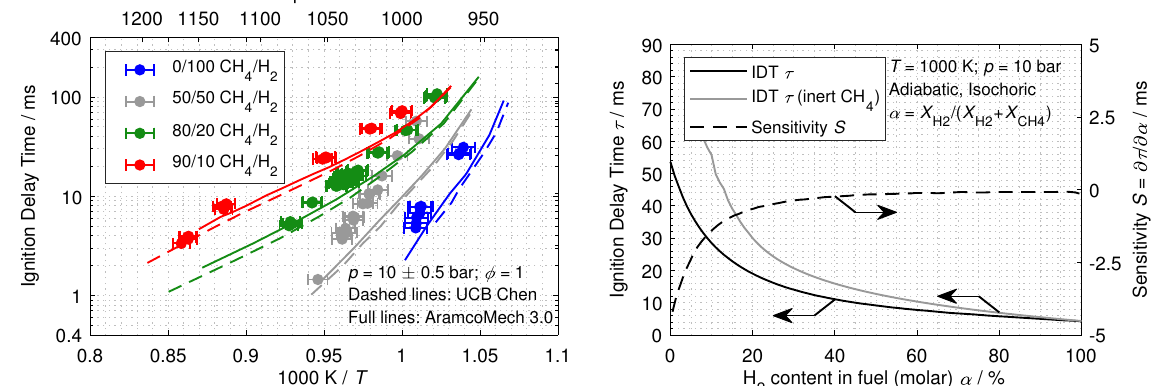
Figure 3. ( Left ): IDT experiments and simulations of different fuels at a constant pressure. Simula- tions were performed with the AramcoMech 3.0 [68] and UCB Chen [69] reaction mechanism. ( Right ): Sensitivity analysis of stoichiometric mixtures with varying CH 4 /H 2 ratios in fuel. Simulations were performed with AramcoMech 3.0